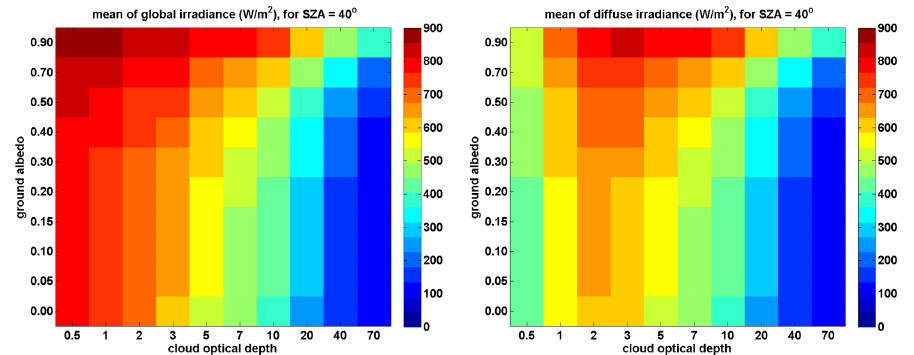
Figure 2. Relative root mean of variance of K c due to changes in P c as a function of ρ g and τ c for θ S = 40 ◦ , for water cloud (left) and ice cloud (right).